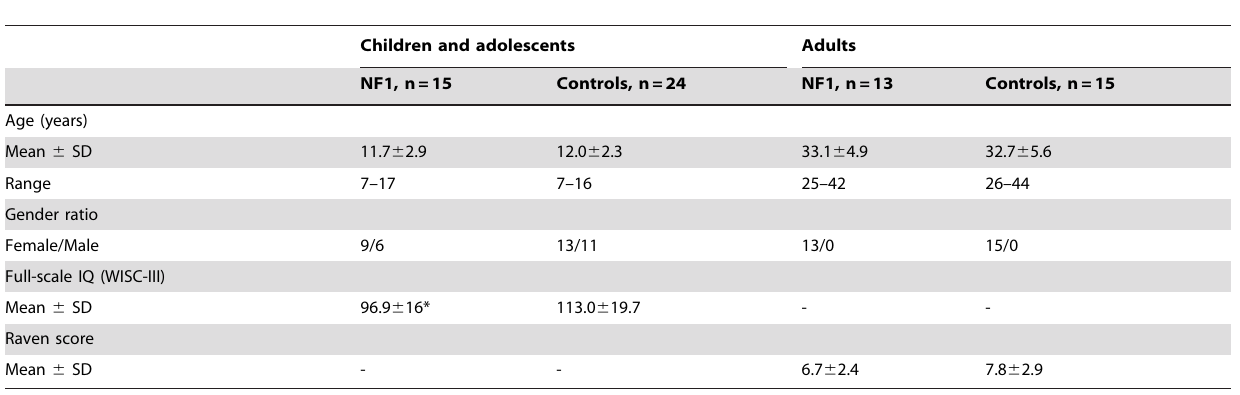
Table 1. Demographic and neuropsychological characteristics of patients and control